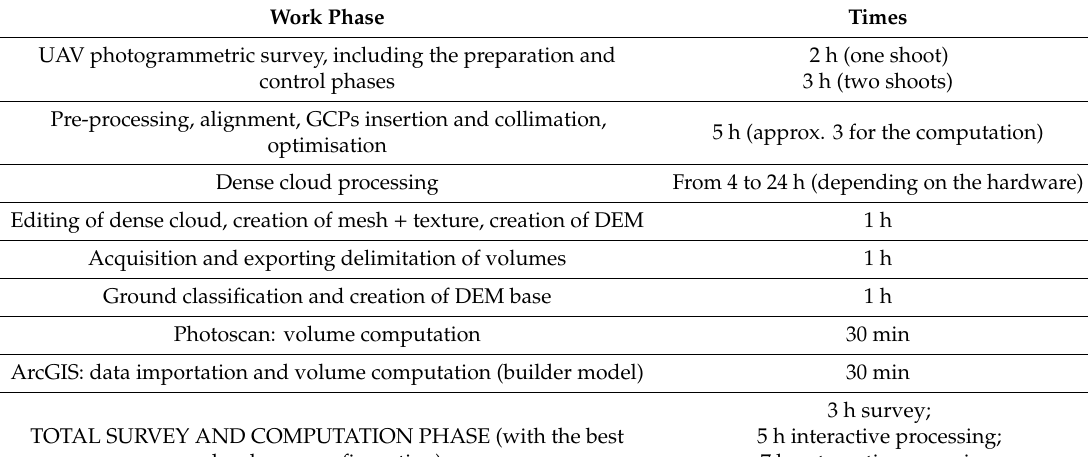
Table 9. Summary of the work times with the UAV photogrammetric survey method. Work Phase